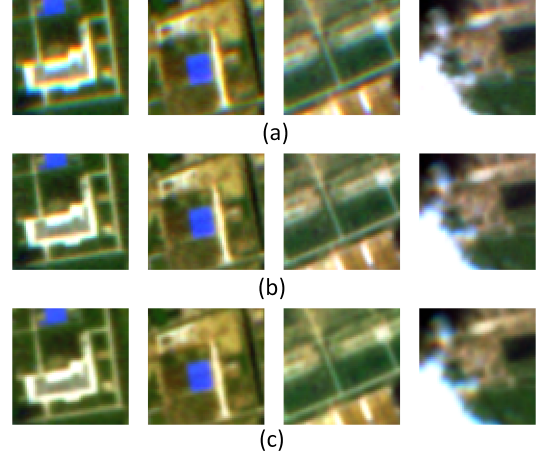
Figure 6. RMSE registration accuracy of “direct method”, “cloud mask method” and our method in 83 cloudy images.